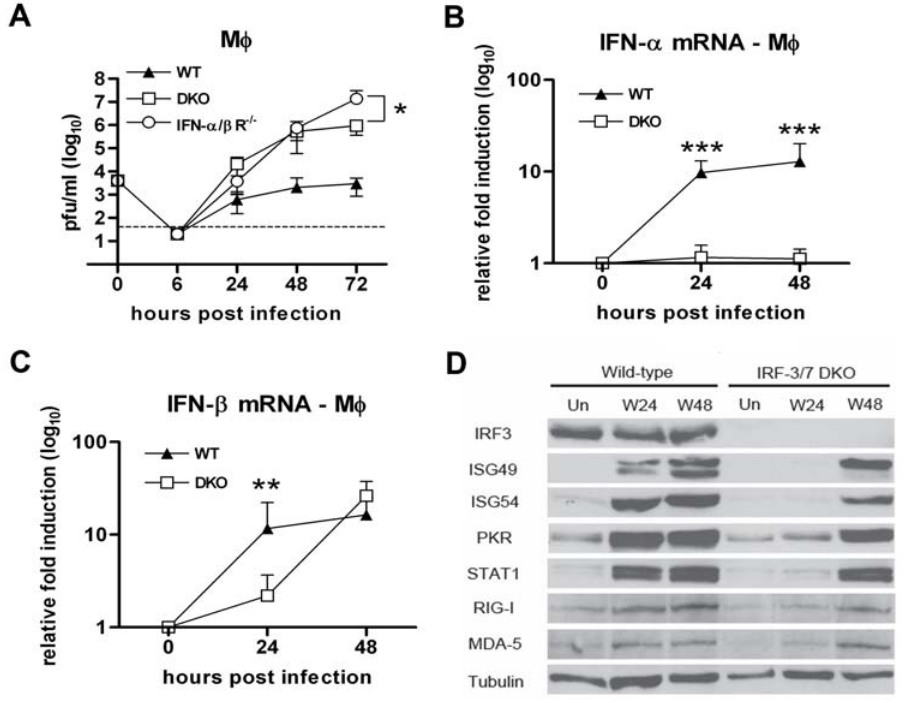
Figure 5. IRF-3 and IRF-7 partially modulate the IFN- b response and ISG expression in primary M w . A . M w generated from wild type, IFN- ab R 2 / 2 and DKO mice were infected at an MOI of 0.01 and virus production was evaluated at the indicated times post infection by plaque assay. Values are an average of quadruplicate samples generated from at least three independent experiments. B . Whole cell lysates were generated at the indicated times from wild type and DKO M w that were uninfected (Un) or infected with WNV (W). Protein levels of ISG49, ISG54, PKR, STAT1, RIG-I, MDA5 and tubulin were examined by immunoblot analysis. C and D . The induction of ( C ) IFN- a and ( D ) IFN- b mRNA in WNV-infected M w was analyzed by qRT-PCR as described in Figure 3. Asterisks indicate values that are statistically significant (***, P , 0.0001, **, P , 0.005, *, P ,